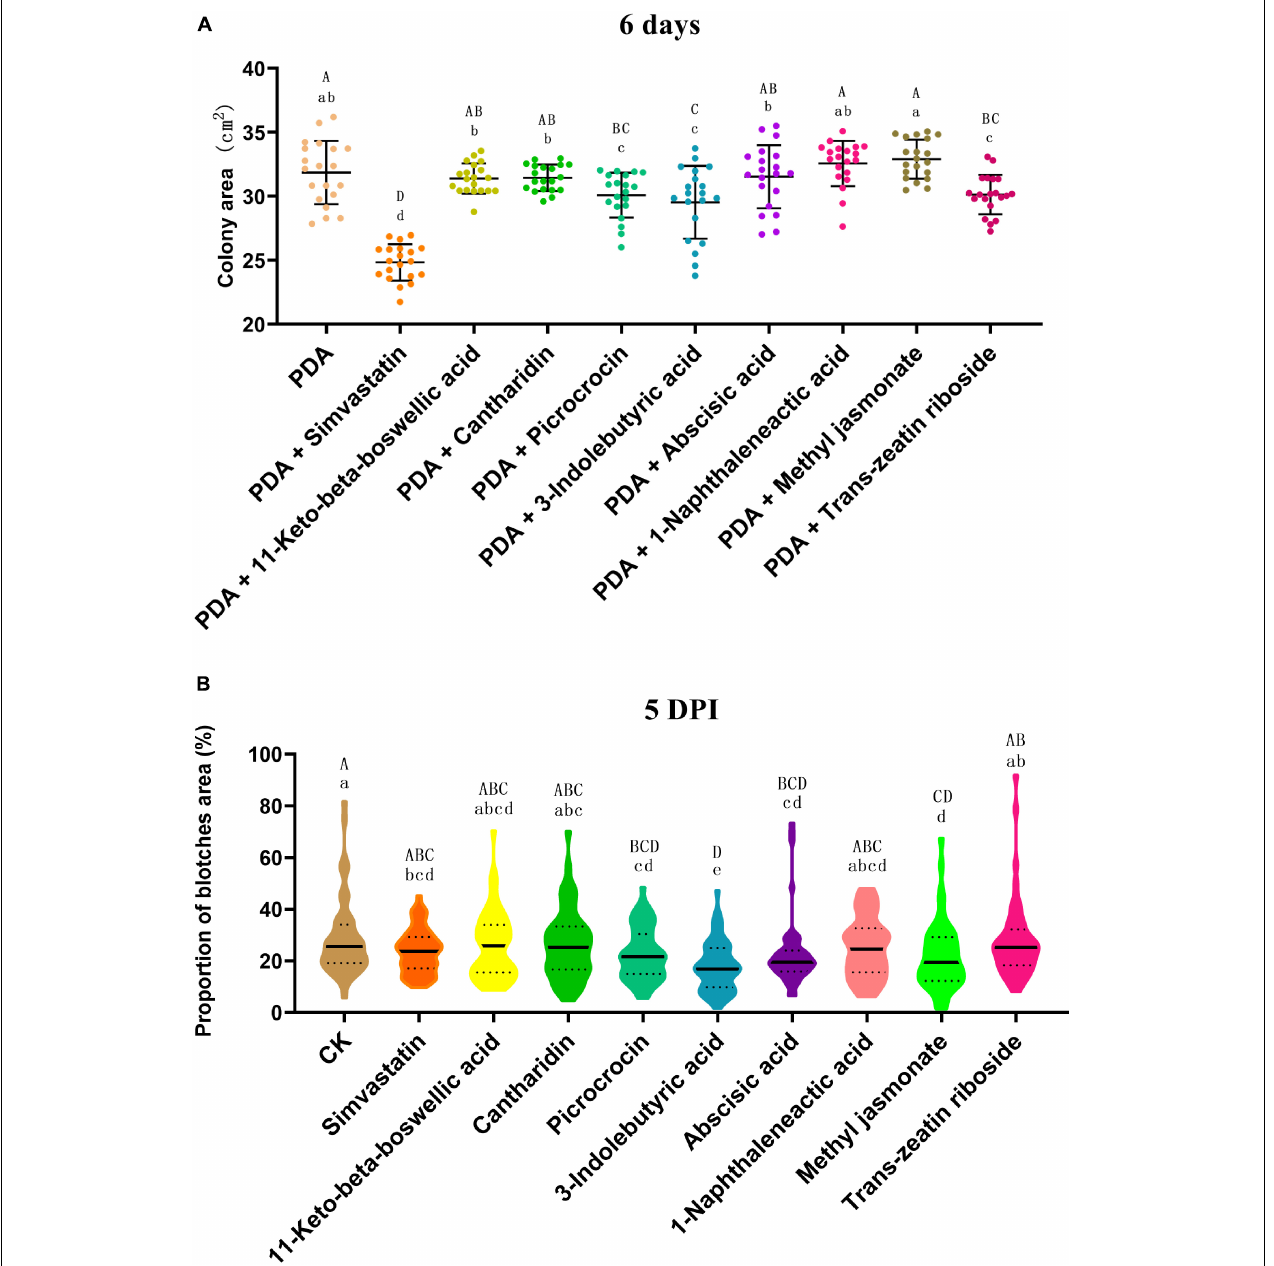
FIGURE 12 | (A) Inhibitory effects of different terpenoids and plant hormones on the growth of Colletotrichum truncatum . The individual values of colony areas and the means ± SD are shown. The acolony areas were scanned and calculated with the LA-S analysis system. Different upper-case and lower-case letters indicate statistical significance at p < 0.05 and p < 0.01, respectively, between individual compounds (Tukey’s HSD test, n = 20). (B) Effects of different terpenoids and plant hormones on the resistance of soybean pods to anthracnose. Violin plots of the proportion of the total blotch area and means ± SD are shown. The blotches were scanned and areas calculated with the LA-S analysis system. Different upper-case and lower-case letters indicate statistical significance at p < 0.05 and p < 0.01, respectively, between individual compounds (Tukey’s HSD test, n = 50).